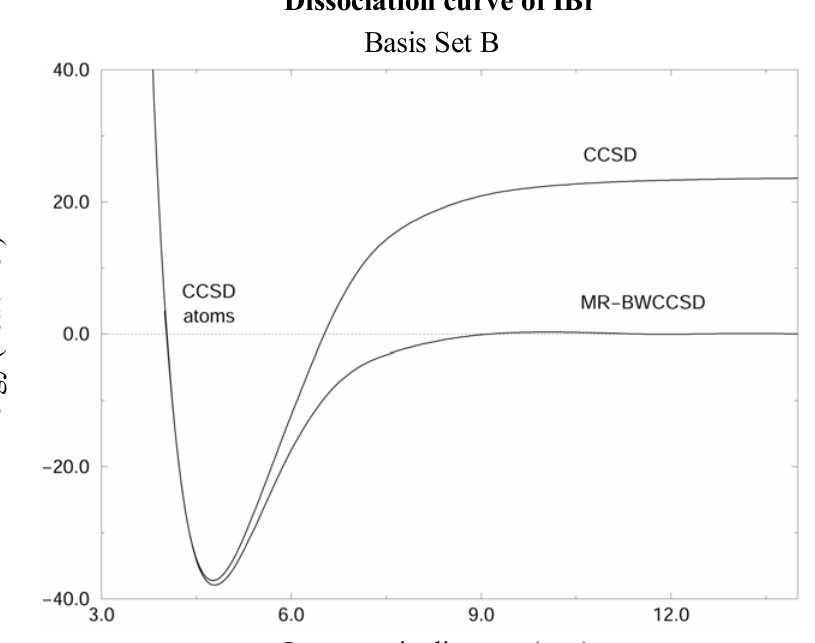
Figure 2. Potential energy curves of the IBr molecule calculated by the CCSD and MR-BWCCSD methods in the basis set B (see text) shown by solid lines. Energy scale is relative to the sum of energies of isolated atoms, which is indicated by the dashed line. Notice the incorrect dissociation limit of the single-reference